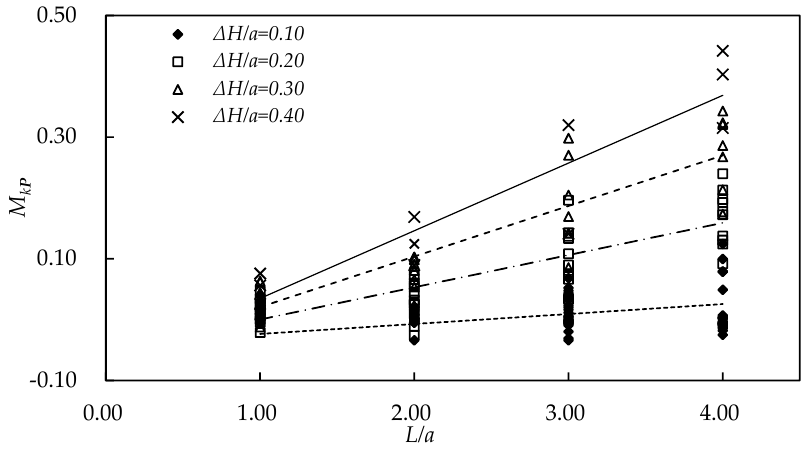
Figure 5. M KP vs. different L/a for Δ H/a = 0.10, 0.20, 0.30 and 0.40.